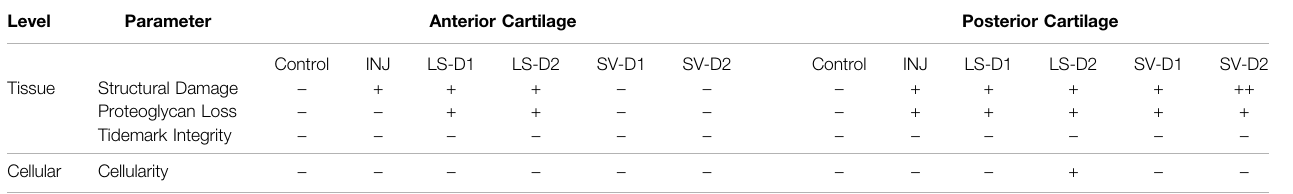
TABLE 2| Histological semi-quantitativescoring of theanterior and posterior cartilage demonstrated altered tissue and cellular properties post-injury and treatment. In both anterior and posterior cartilage, INJ caused minor surface irregularities compared to Control. In the anterior cartilage, both SV strategies could slightly prevent these minor surface irregularities, whereas LS had no bene fi t and even caused a loss of proteoglycan matrix staining. Posteriorly, no strategy provided cartilage protection; in fact, SV strategies worsened the severity of cartilage damage. Note: Histological parameters were semi-quantitatively assessed and given a symbol of either − , +, ++, +++, or ++++, where increases in the number of symbols (+vs. ++++) indicate worse disease severity; details on grading scheme is found in Supplementary Table S1 ; Control (cid:1) uninjured, age-matched; INJ (cid:1) injury no drug; LS-D1 (cid:1) losartan dosing strategy 1; LS-D2 (cid:1) losartan dosing strategy2; SV-D1 (cid:1) simvastatindosing strategy1; and SV-D2 (cid:1) simvastatin dosing strategy